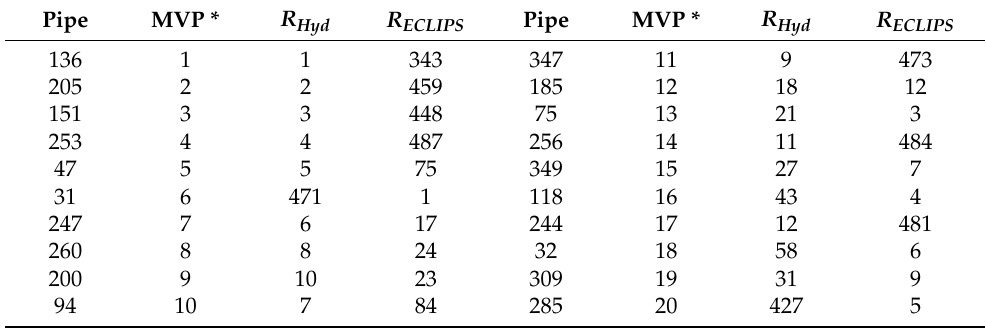
Table 2. Comparison of priorities of the 20 pipes identified as the highest priority for replacement based on the minimum variance portfolio (i.e., weighted combination of R Hyd and R ECLIPS ). Shown for comparison are the replacement priorities of the pipe based on R Hyd or R ECLIPS